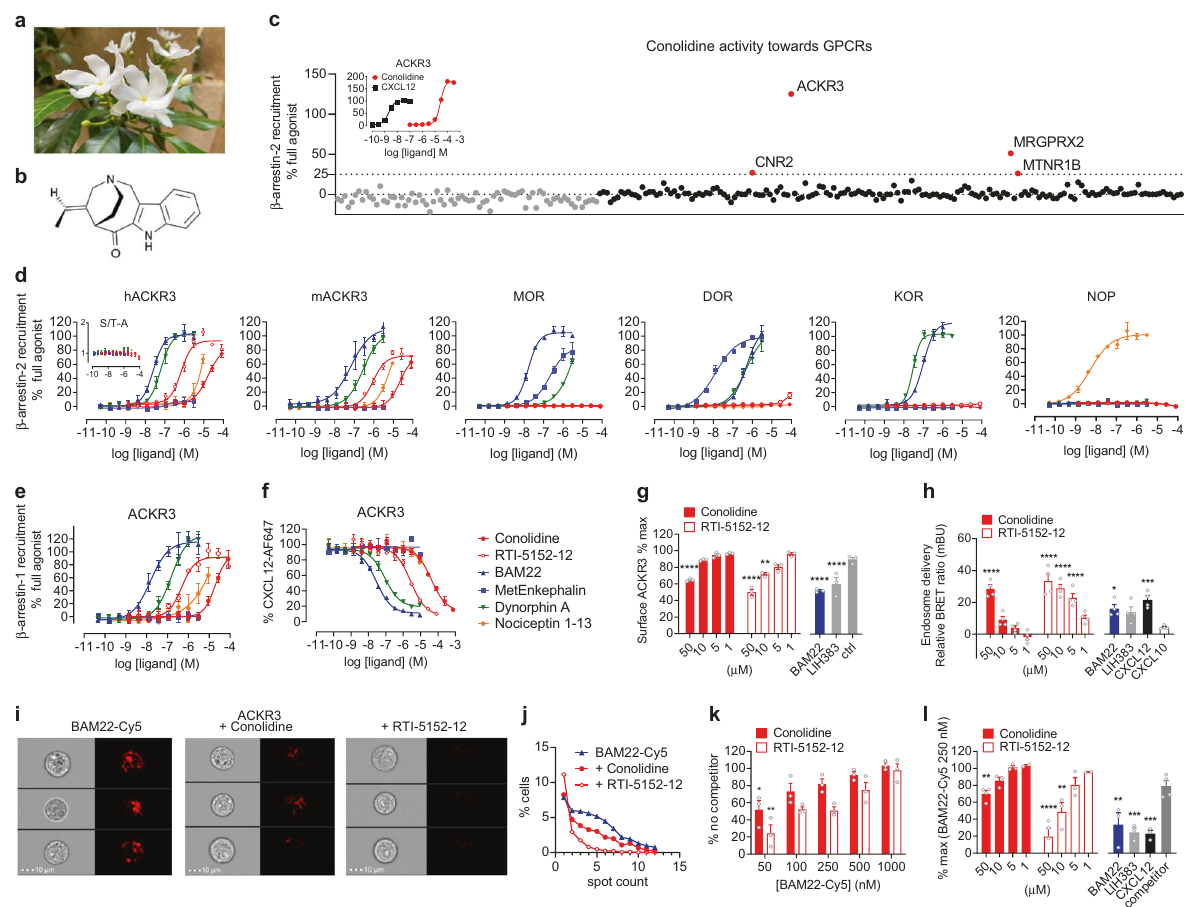
Fig. 1 Conolidine acts as an agonist of the opioid scavenger ACKR3. a The pinwheel fl ower or Crepe Jasmine ( Tabernaemontana divaricata ). b Structure of conolidine with its C5-nor stemmadenine core. c Screening of conolidine (10 µM) towards the 74 GPCRs of orphanMAX panel (grey) and the 168 GPCRs of gpcrMAX panel (black) using a β -arrestin-2 recruitment assay based on β -galactosidase complementation (PathHunter, DiscoverX) in CHO-K1 cells. The full list of receptors and positive controls is available at www.discoverx.com. Inset. Potency and ef fi cacy of CXCL12 and conolidine towards ACKR3 in a β -arrestin-2 recruitment assay (PathHunter). Conolidine triggered β -arrestin-2 recruitment to ACKR3 with a potency of 27 µM and ef fi cacy of 185% compared to CXCL12. d, e Comparison of the potency and ef fi cacy of conolidine and its analogue RTI-5152-12 with representative opioid peptides from the enkephalin (BAM22, Met-Enkephalin), dynorphin (Dynorphin A) and nociceptin (Nociceptin 1 – 13) family in activating human and mouse ACKR3 and the classical opioid receptors MOR, DOR, KOR, NOP using a β -arrestin-2 ( d ) or β -arrestin-1 ( e ) recruitment assay based on Nanoluciferase complementation (NanoBiT) in U87 cells. Inset. β -arrestin-2 recruitment to mutated ACKR3 lacking the C-terminal GRK phosphorylation sites (S/T-A) in response to conolidine, RTI-5152-12 and opioid peptides. Data are expressed as percentage of full agonist response: CXCL12 for ACKR3, BAM22 for MOR, Met-Enkephalin for DOR, Dynorphin A for KOR and Nociceptin 1 – 13 for NOP or as fold baseline for inset. Conolidine triggered β -arrestin-2 recruitment to human and mouse ACKR3 with potency of 16 µM and 22 µM, respectively, and β -arrestin-1 recruitment to human ACKR3 with potency of 19 µM. f Binding competition of conolidine and its analogue RTI-5152-12 and representative opioid peptides with Alexa Fluor 647-labeled CXCL12 (5 nM) on U87-ACKR3 cells determined by fl ow cytometry. The experiment was performed on ice to prevent ligand-induced internalization. g ACKR3 internalization in response to conolidine and its analogue RTI-5152-12 in comparison to BAM22, LIH383 and control peptide (1 µM) used as positive and negative controls. Following a brief acidic wash to remove receptor-bound ligands, the presence of ACKR3 at the cell surface was monitored by fl ow cytometry using an anti-ACKR3 mAb (clone 11G8). h ACKR3 delivery to the early endosomes in response to conolidine and RTI-5152-12, CXCL12 (1 µM) or peptides BAM22 and LIH383 (1 µM) monitored by NanoBRET-based assay in U87 cells using ACKR3- Nanoluciferase as donor and FYVE domain of endo fi n, interacting with phosphatidylinositol 3-phosphate (PI3P) in early endosomes, fused to the mNeonGreen fl uorescent protein, as acceptor. Chemokine CXCL10 was used as negative control. i ACKR3-mediated uptake of Cy5-labeled BAM22 (250 nM) in competition with conolidine and RTI-5152-12 (50 µM) visualized in U87-ACKR3 cells by imaging fl ow cytometry. Three representative cells per condition are shown out of 5000 single, in focus, living cells recorded. Scale bar: 10 µm. j Percentage of cells with a given number of distinguishable vesicle-like structures (spots) representative of three independent experiments. k ACKR3-mediated uptake of Cy5-labeled BAM22 (50 nM – 1 µM) in competition with conolidine (50 µM) or RTI-5152-12 (10 µM) visualized in U87-ACKR3 cells by imaging fl ow cytometry. l Uptake competition between Cy5-labeled BAM22 (250 nM) and varying concentrations of conolidine and RTI-5152-12 (50, 10, 5, 1 µM) or CXCL12, BAM22 and LIH383 (1 µM) used as positive controls in U87-ACKR3 cells. Data are presented as mean ± S.E.M. of three (four for h) independent experiments ( n = 3 or n = 4). * p < 0.05, ** p < 0.01, *** p < 0.001, **** p < 0.0001 by one-way ANOVA with Bonferroni ’ s post hoc test ( g, h , l ) or repeated measures one-way ANOVA with Dunnet ’ s post hoc test ( k ). Source data are provided as a Source Data fi